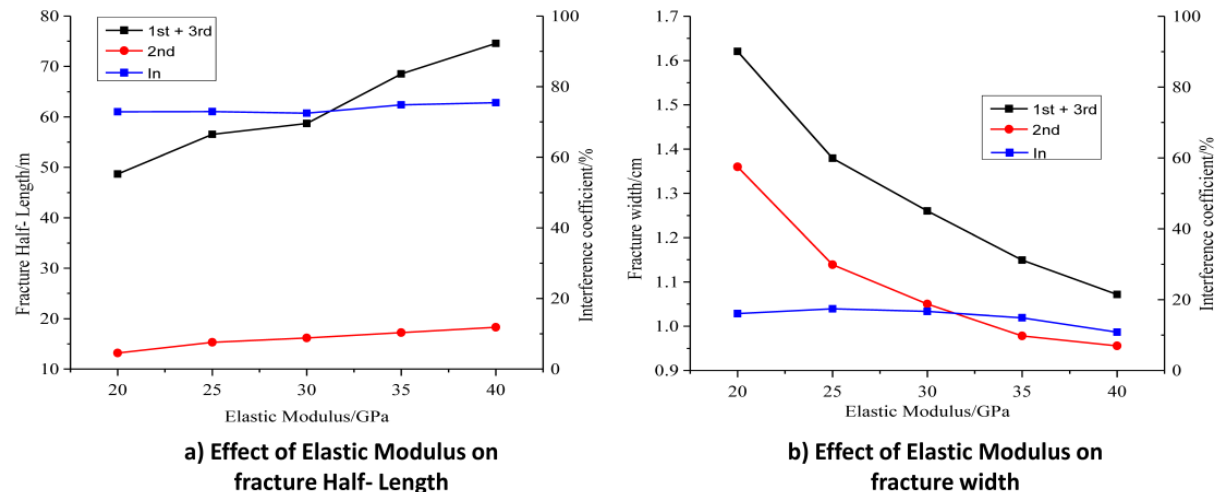
Figure 6: Results of fracture morphology for fracture propagation when the elastic modulus of reservoir is